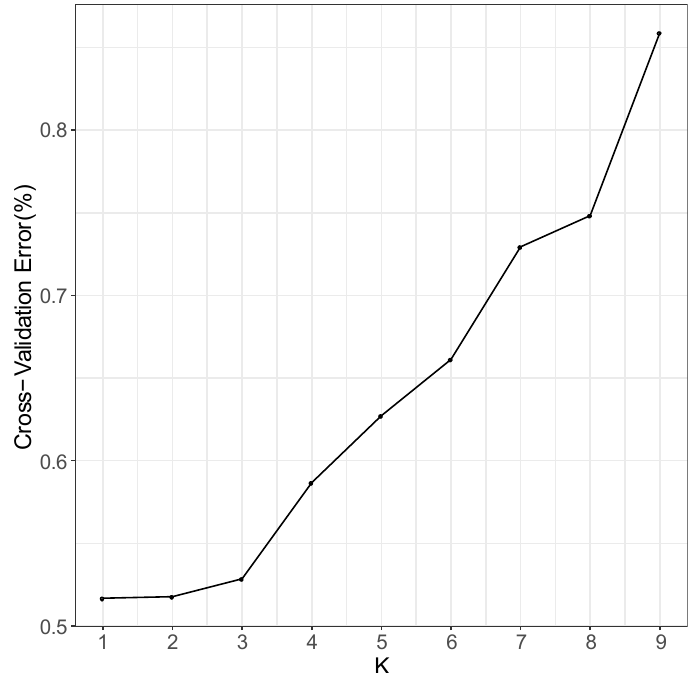
Figure 2. Cross-validation error value.